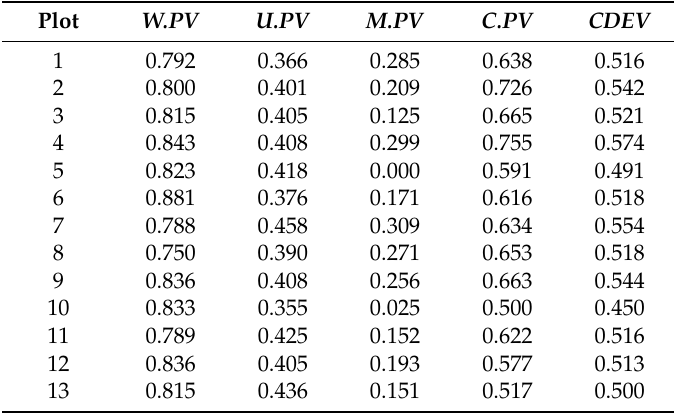
Table 8. Optimal distance evaluation of forest spatial structure in different thinning plots. Plot W.PV U.PV M.PV C.PV